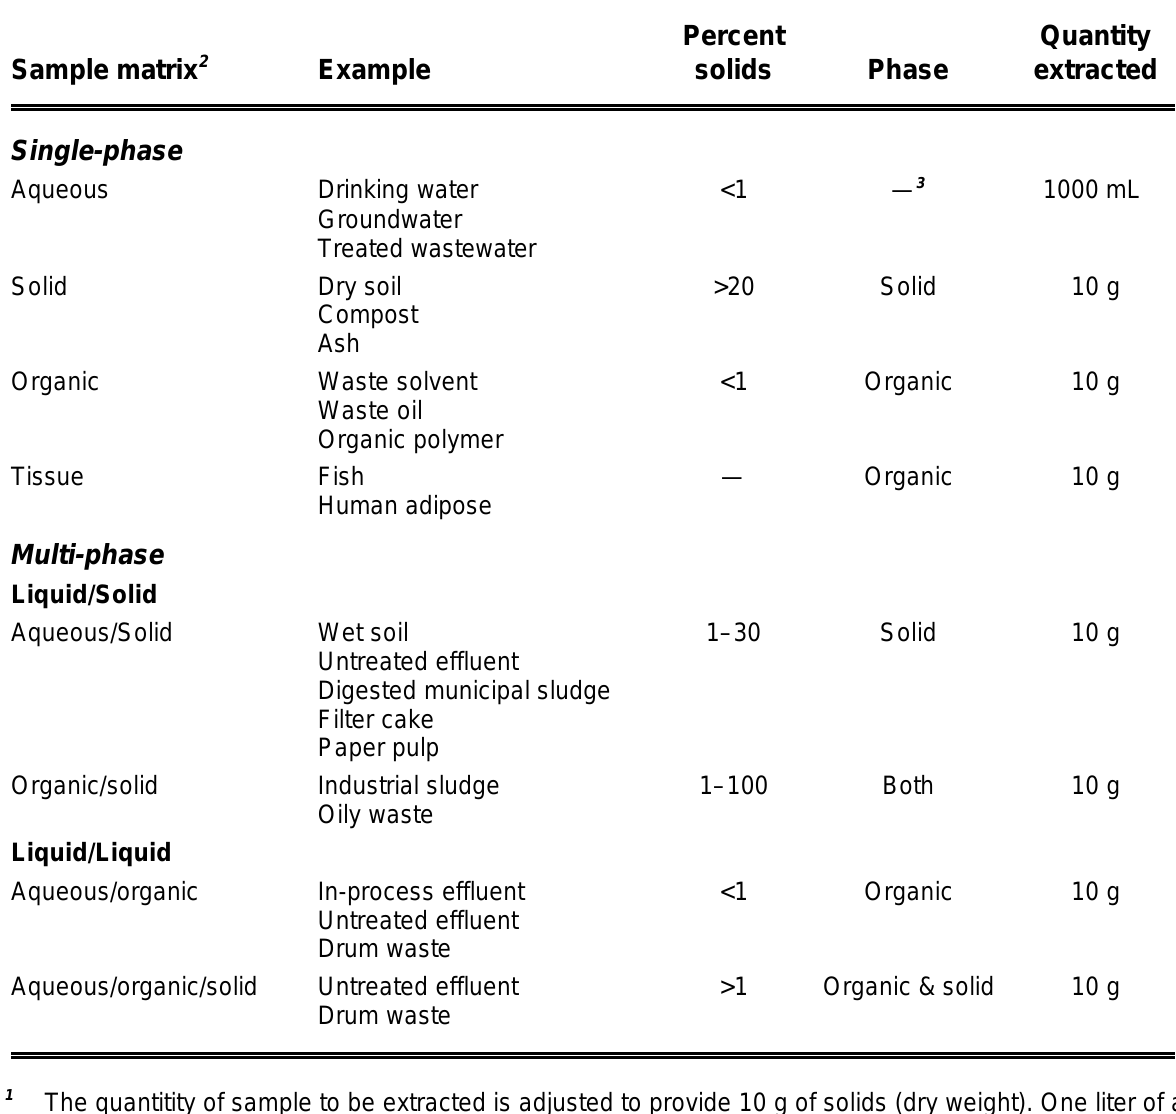
Table 10. Suggested Sample Quantities to be Extracted for Various Matrices